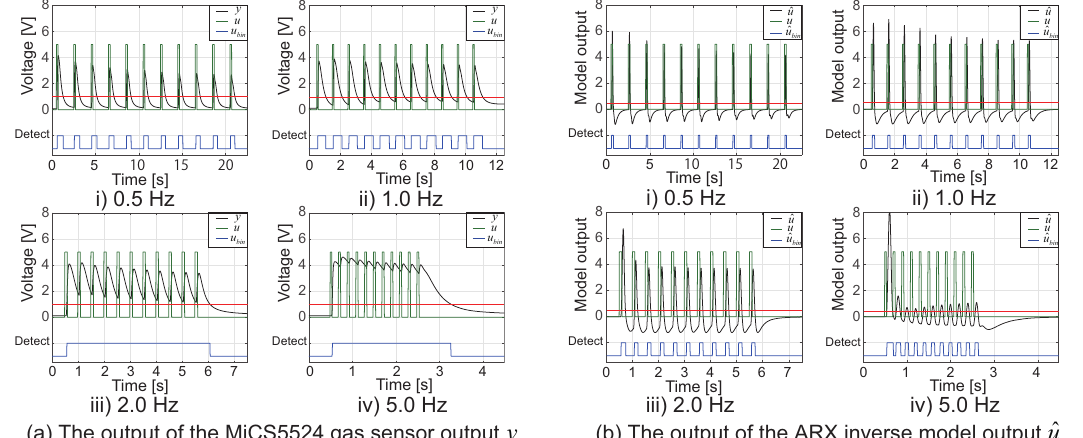
Figure 4. The MiCS5524 gas sensor response and ARX inverse model result for periodic odor stimuli. The green line represents the opening/closing timing of the solenoid valve (stimulation supply timing), and the blue line represents the result of binarizing y or ˆ u with the threshold value (red line). The black lines of ( a , b ) indicate MiCS5524 gas sensor output y (V) and estimated input ˆ u calculated by using ARX inverse model, respectively. We set thresholds for y and ˆ u to “1” and “0.5”, respectively.